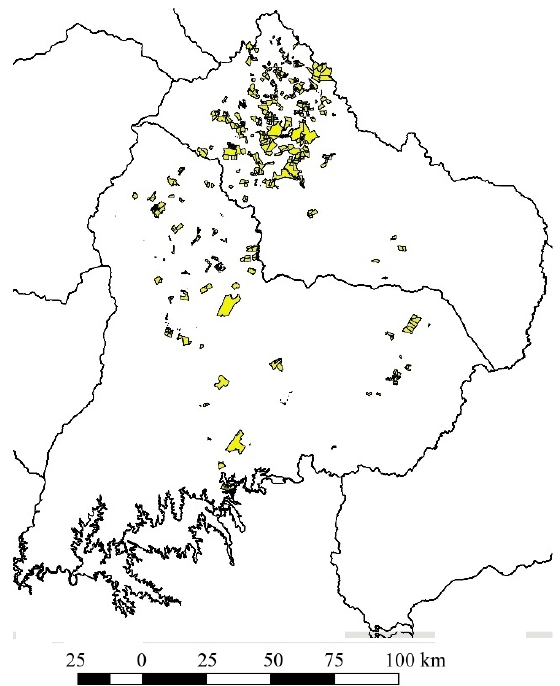
Figure 5. Eucalyptus grandis plantations for sawmilling and plywood purposes in Rivera and Tacuarembó (in